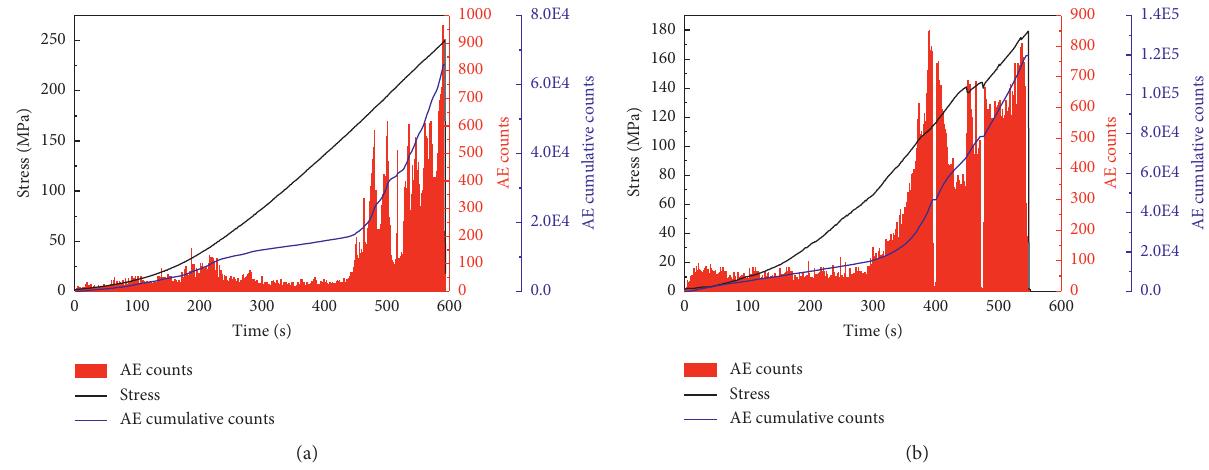
Figure 7: AE counts and cumulative count evolution of the intact specimen (a) and the intact specimen containing an opening (b).